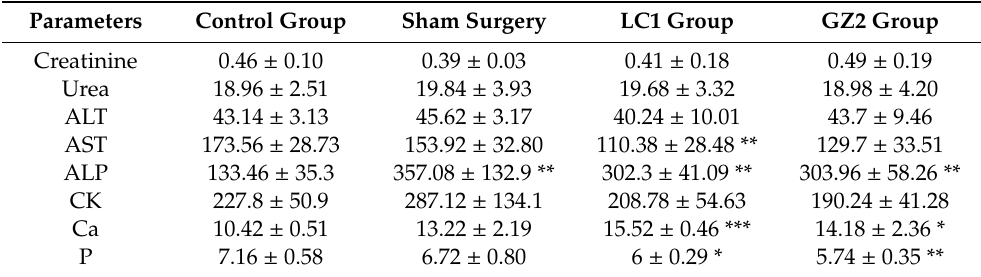
Table 4. Changes in biochemical parameters in response to the surgical bone defect and graphene dental materials treatment.